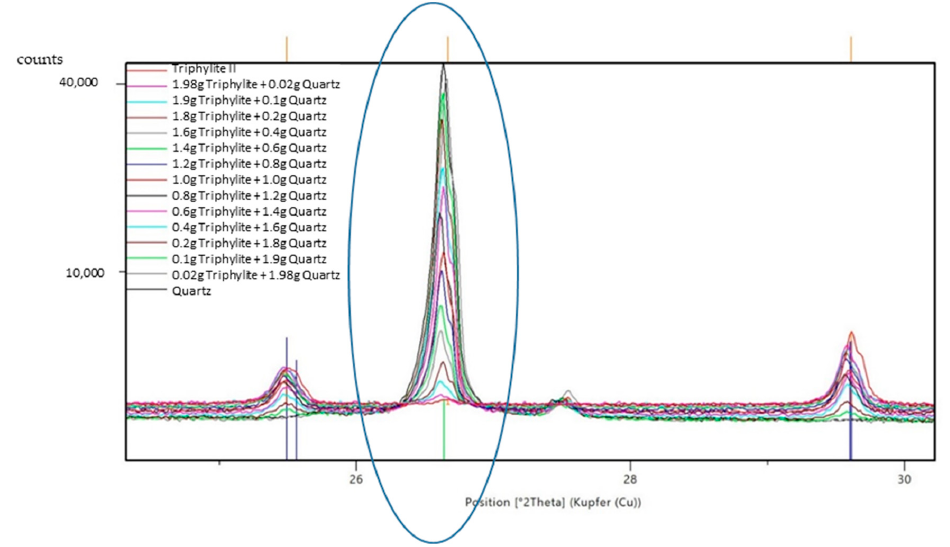
Figure 14. Main peak of quartz in triphylite–quartz calibration mixtures. Figure 15. Main peak of quartz in triphylite–quartz calibration